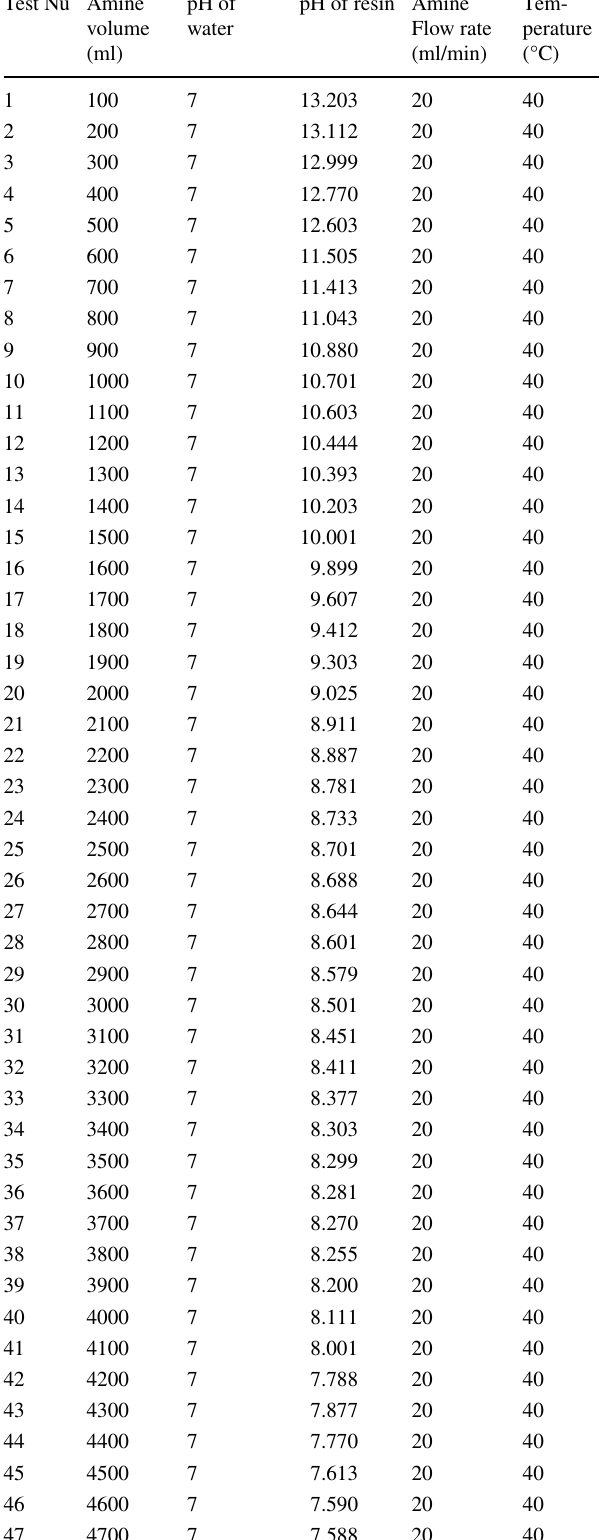
Table 5 Results of distilled water passage in order to eliminate the alkalinity of the resin at 40 °C Test Nu Amine